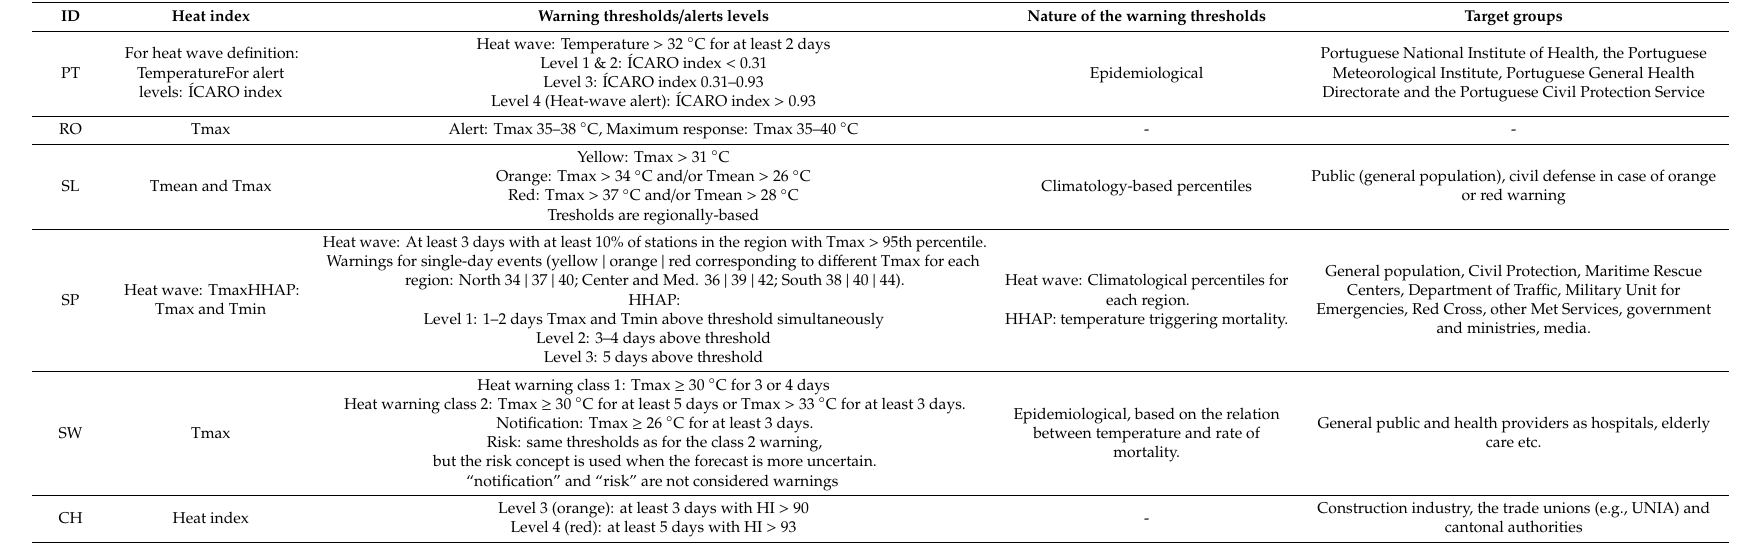
Table 2. Cont. Warning thresholds / alerts levels Nature of the warning thresholds Target groups